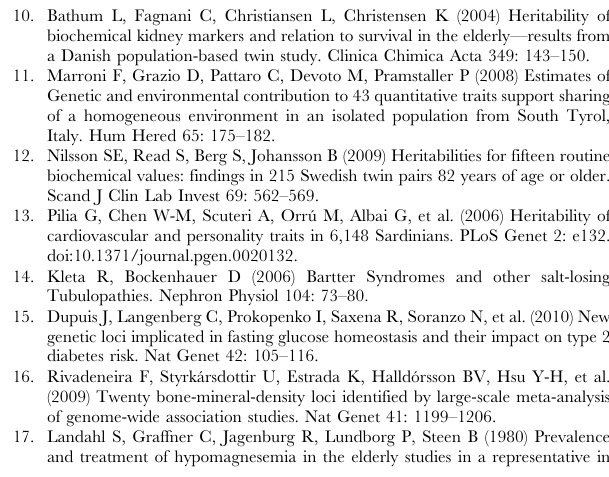
Table S7 Imputation quality for SNPs with significant and suggestive association with serum magnesium concentrations.